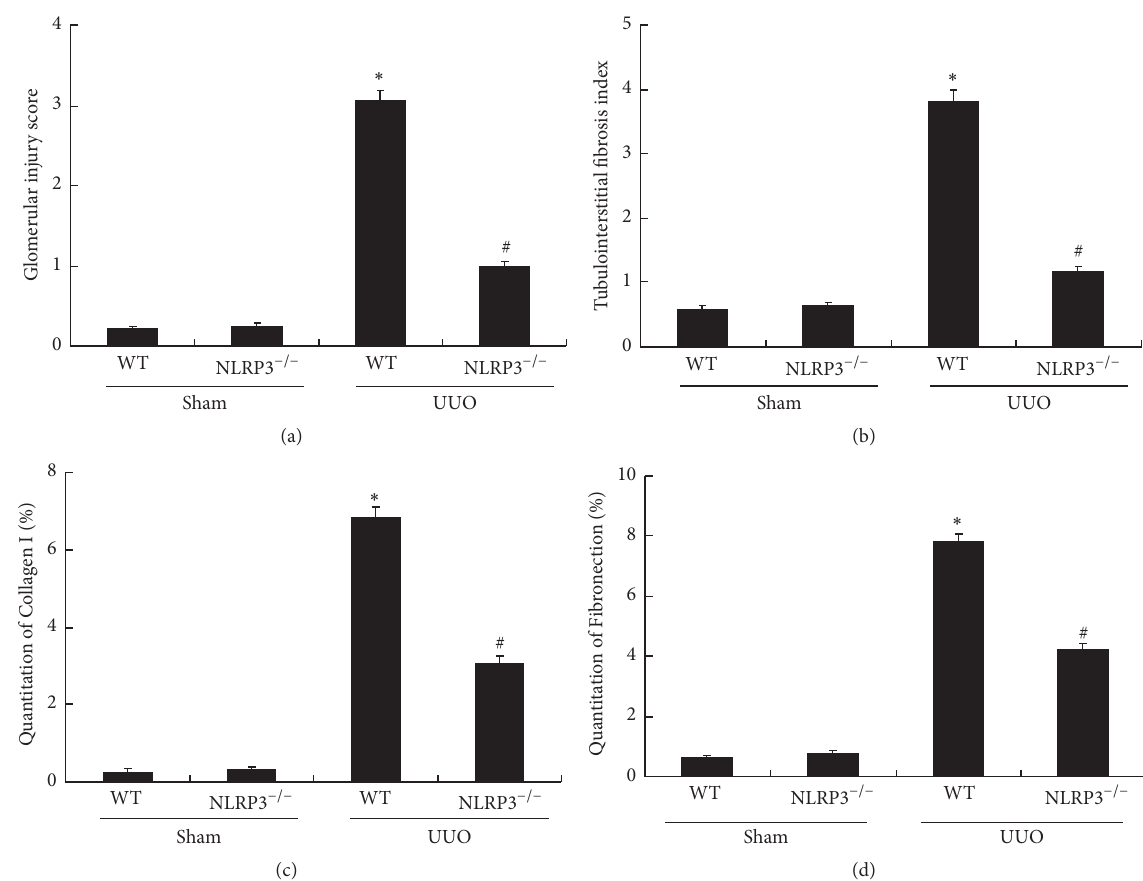
Figure 3: NLRP3 deletion attenuates UUO-induced glomerular injury and tubulointerstitial fibrosis as well as deposition of collagen I and fibronectin. Glomerular injury score (a) and tubulointerstitial fibrosis index (b) are evaluated according to PAS staining and Masson staining. Semiquantitative analysis of collagen I (c) and fibronectin (d) positive areas is performed according to immunohistochemical staining. Data represent the mean ± SEM ( 𝑛 = 6 ). ∗ 𝑃 < 0.05 , WT/Sham group versus WT/UUO group; # 𝑃 < 0.05 , NLRP3 −/− /UUO group versus WT/UUO